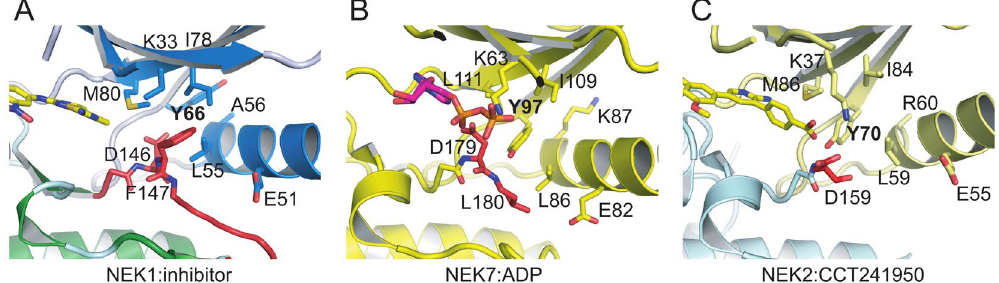
Figure 3. DFG and α C-helix conformations. Tyr66 of NEK1 does not rotate into the binding site as seen for Tyr97 of NEK7 or Tyr70 of NEK2, although all structures are in the inactive state with similar positions of helix α C. ( A ) View of the DFG motif and α C-helix of NEK1. The DFG motif is in a “DFG-out” inactive conformation, shown in red, and the α C-helix containing residues Leu55, Ala56 and Glu51 is in blue. The salt bridge between Lys33 and Glu51 that would be expected in an active state of NEK1 is absent, helix α C is moved outward, and Lys33 is partly disordered. ( B ) View from the same angle as A of the DLG motif of NEK7 (equivalent to NEK1 DFG motif) with the DL in red (Gly181 is disordered). Figure based on the structure